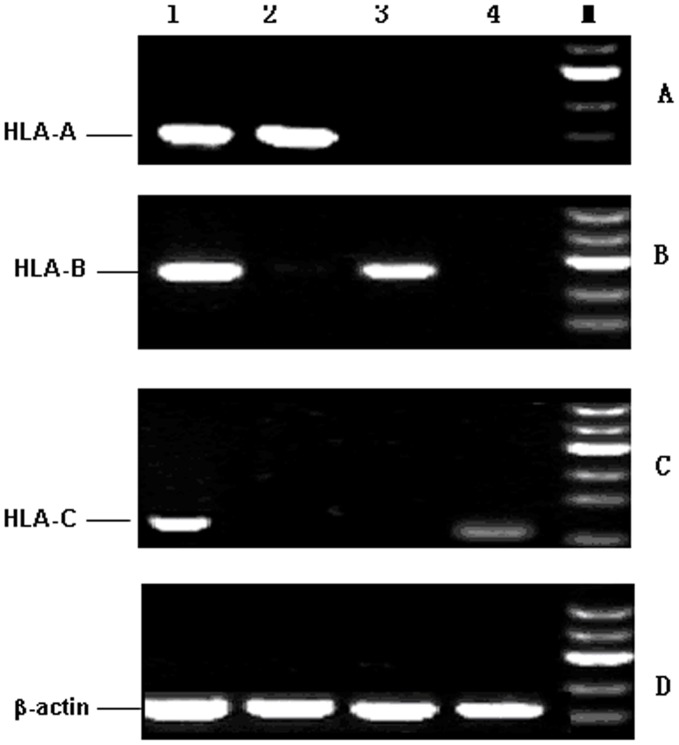
mRNA expression patterns of HLA-A, HLA-B and HLA-C (A–C).M: 100–600 bp marker ladders. Lanes 1 show normal cervical tissue, 2 and 3 shows CIN, 4 shows CSCC tissue. mRNA levels were normalized to β-actin mRNA (D). The lack mRNA expression of a single allele of HLA-I will affect the normal surface expression of HLA-I molecules according to protein detected by IHC.